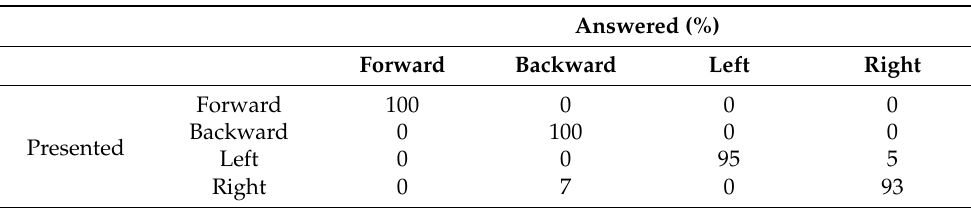
Table 2. Navigational instruction recognition rates with the user interface and the proposed tactile rendering approach.